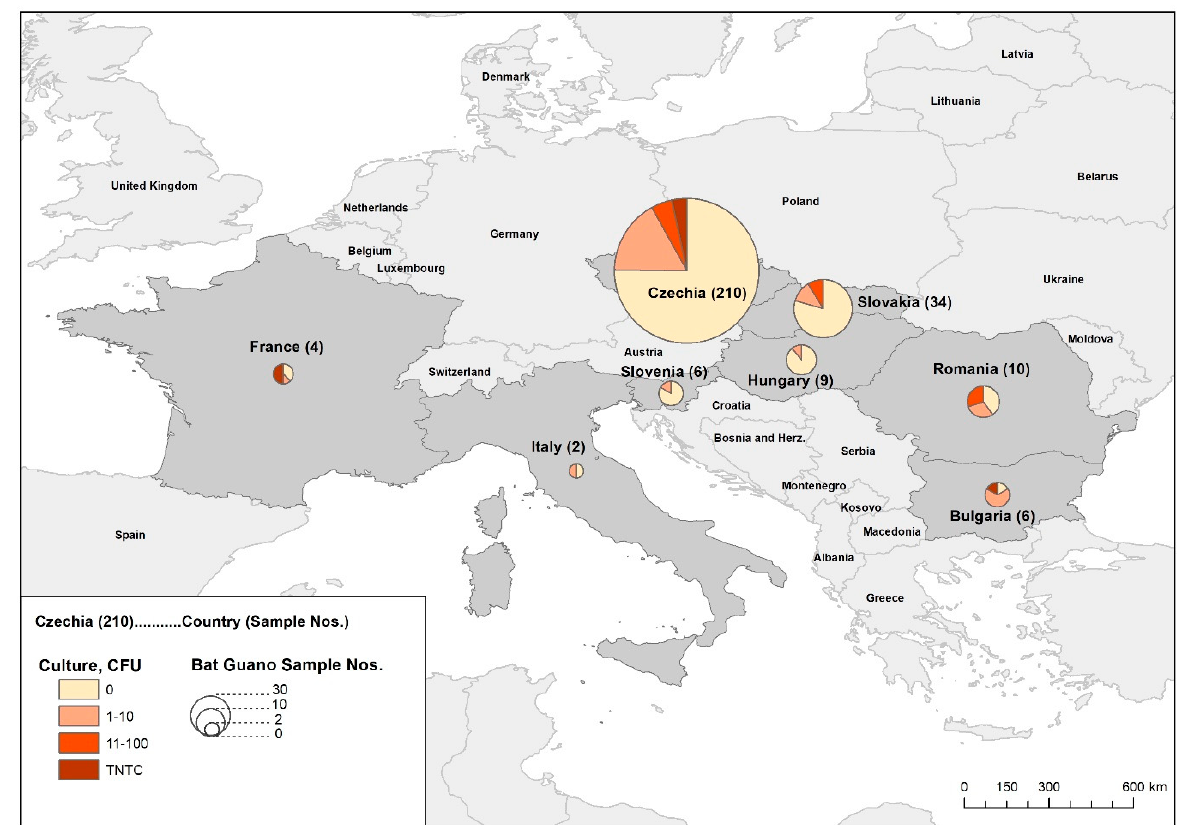
Table 2. Mycobacteria detection in caves’ and attics’ guano samples.